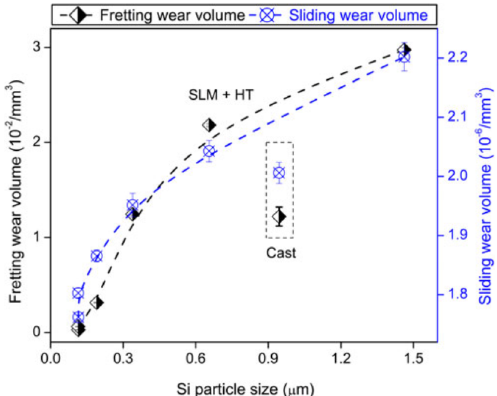
Figure 68. Fretting and sliding wear volumes for the as-cast and SLM Al-12Si specimens as a function of the average Si particle size [205]. Copyright 2014. Adapted with permission from Cambridge